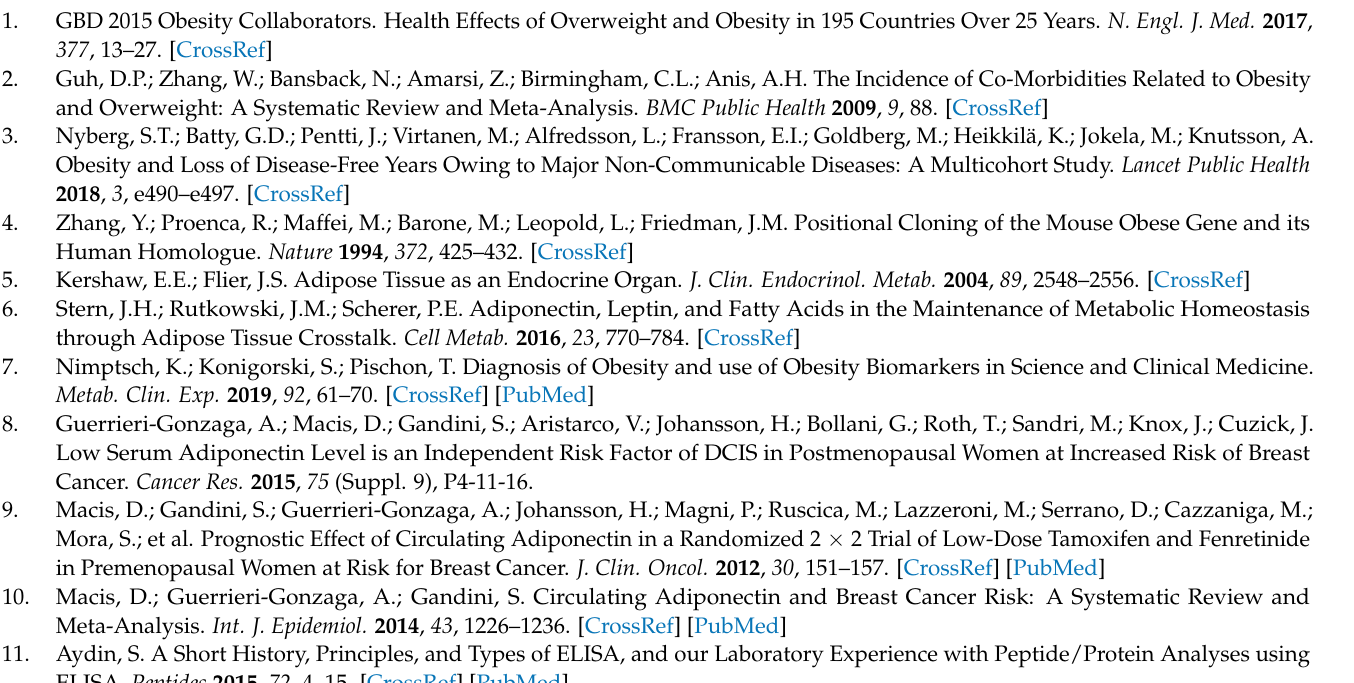
Figure S1: Disease-free survival curves for different quartiles of adiponectin and